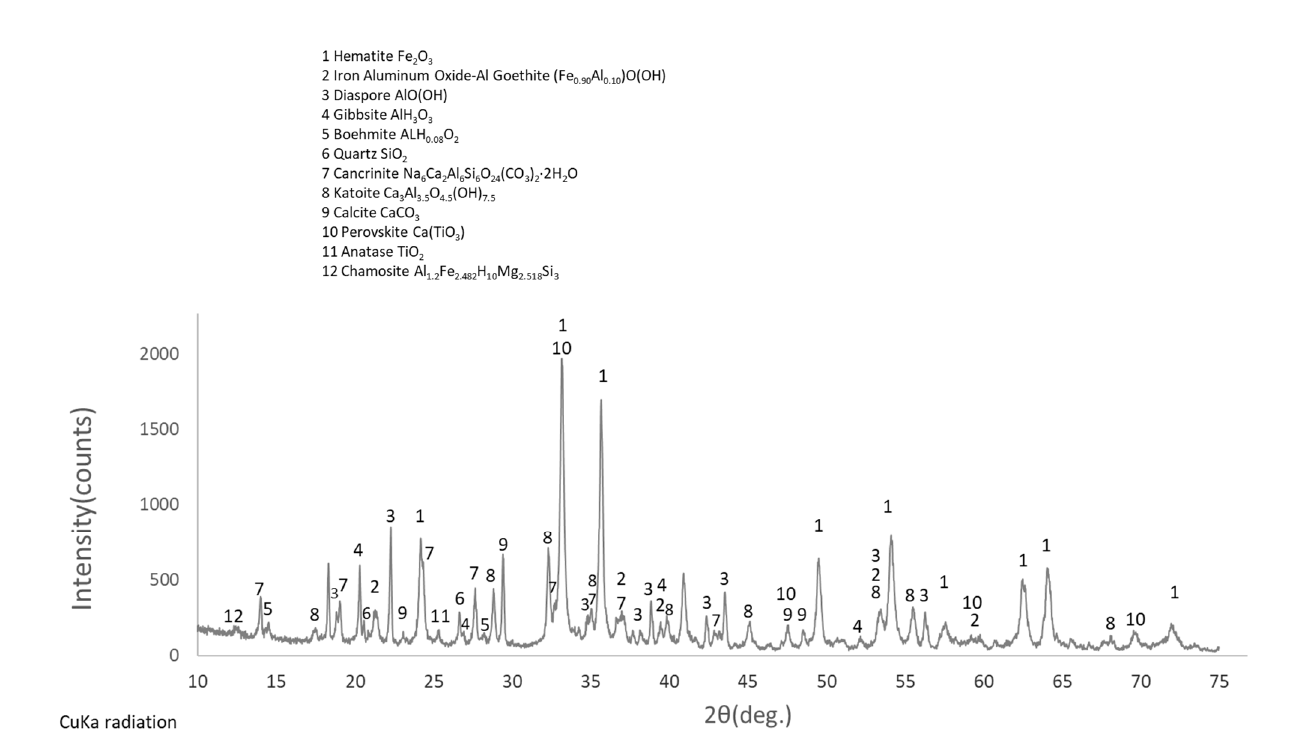
Figure 1. X-ray diffraction of bauxite residue.